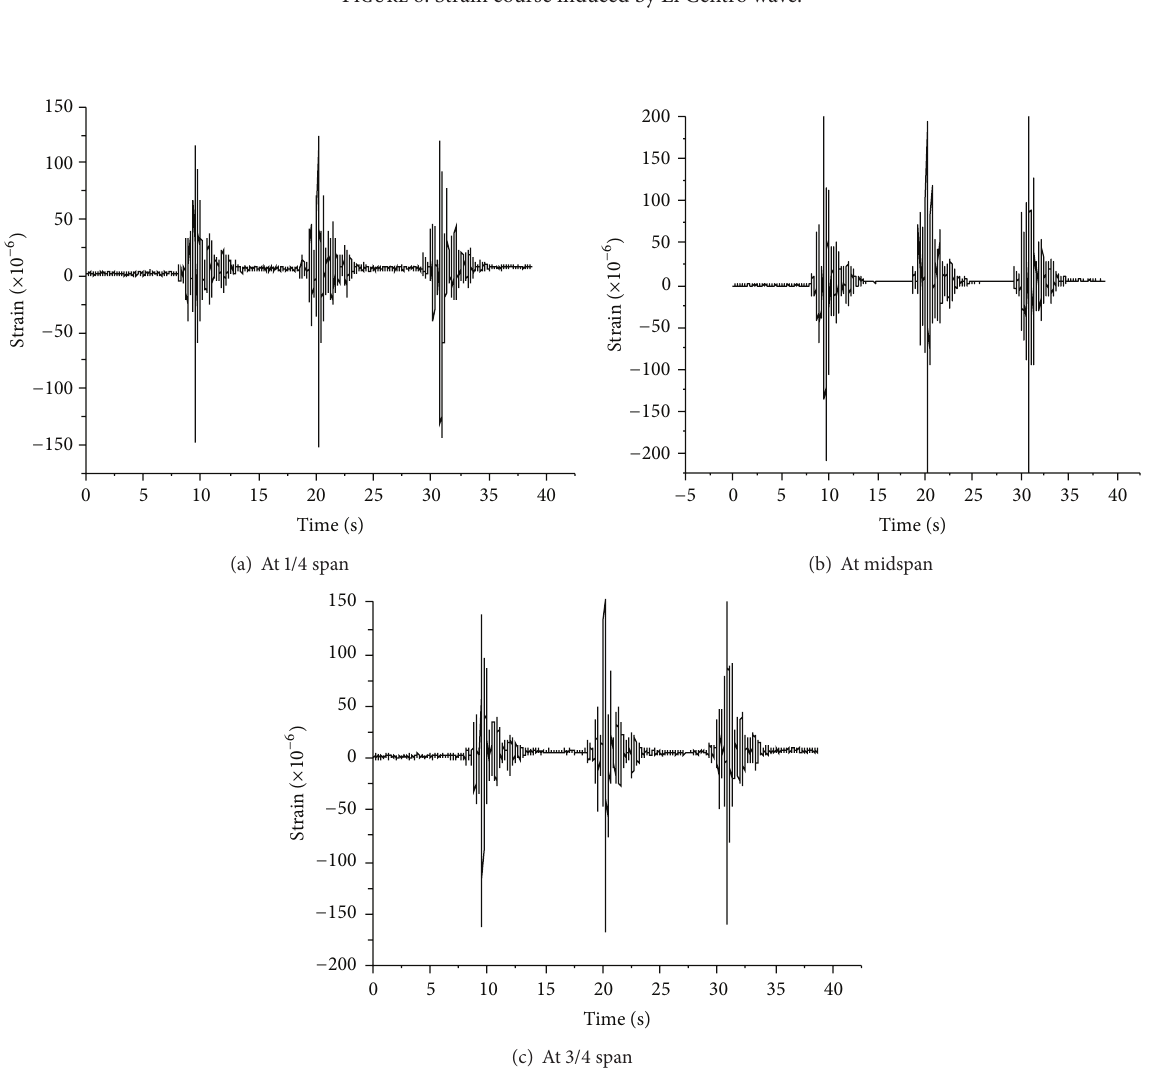
Figure 8: Strain course induced by El Centro wave.